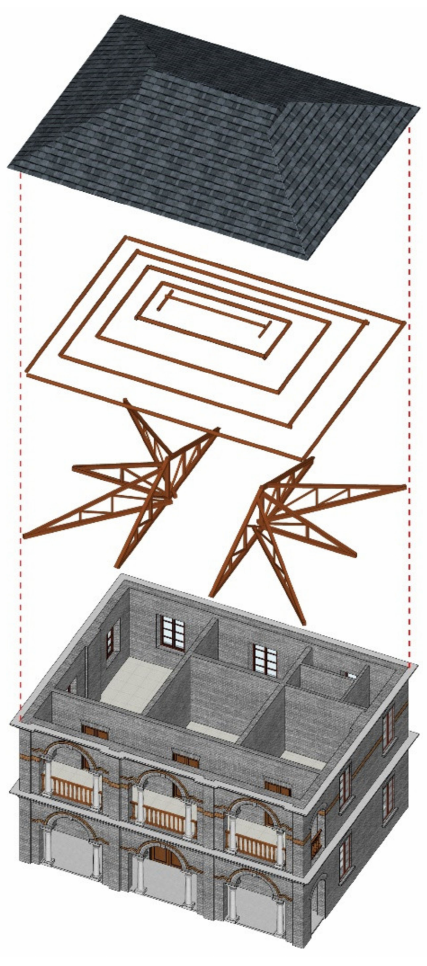
Figure 15. Diagram of the Priest’s Residence.